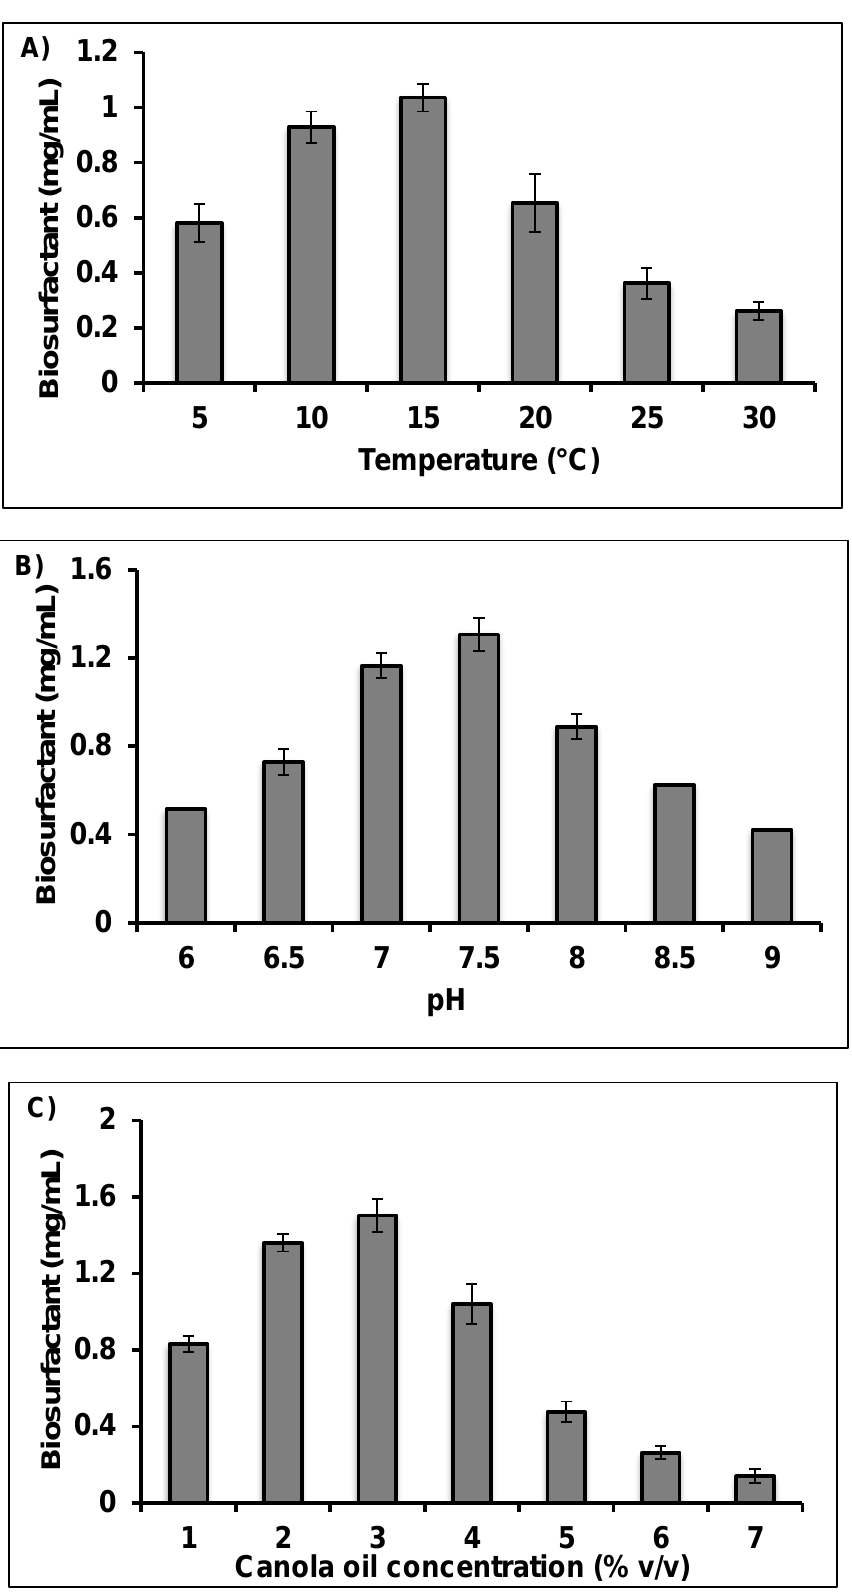
Figure 4. Effect of different environmental variables, ( A ) temperature, ( B ) pH and ( C ) canola oil concentrations on the biosurfactant produced by Rhodococcus erythropolis AQ5-07. Error bars represent mean ± standard deviation, 𝑛 = 3.